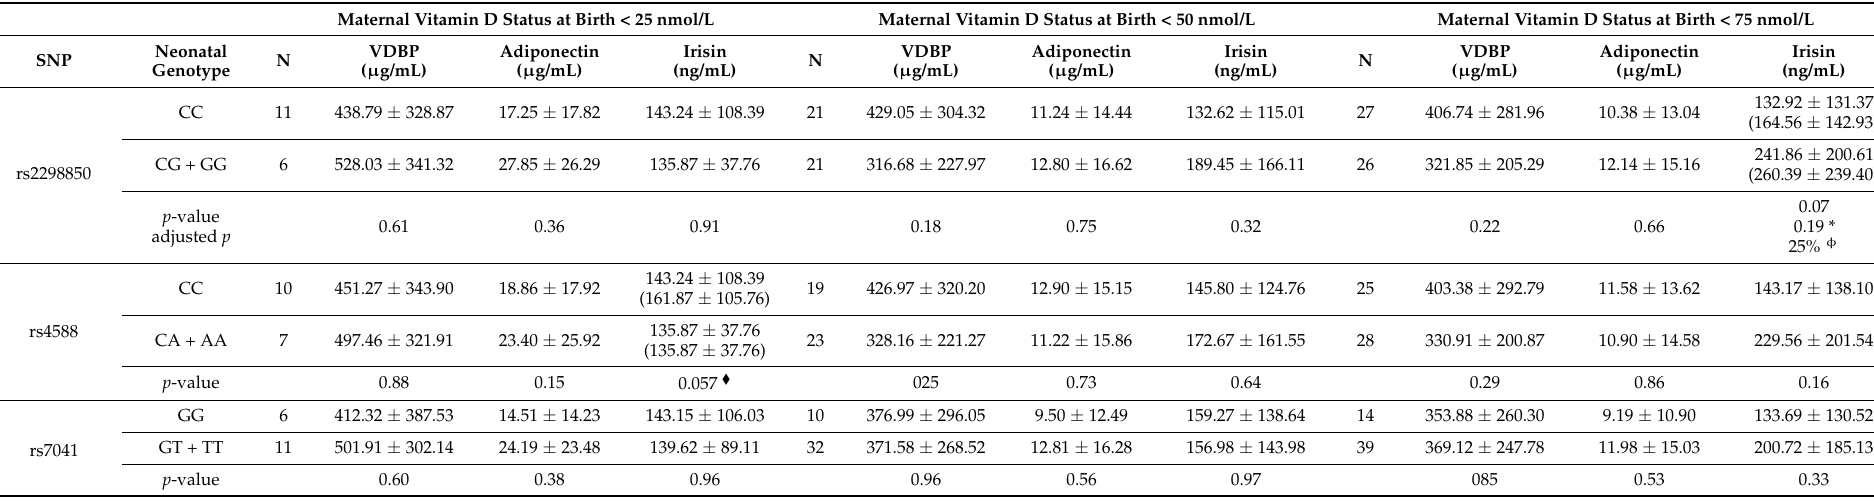
Table 6. Neonatal serum biomarkers according to maternal vitamin D status at birth and neonatal VDBP polymorphisms. Maternal Vitamin D Status at Birth < 25 nmol/L Maternal Vitamin D Status at Birth < 50 nmol/L Maternal Vitamin D Status at Birth < 75